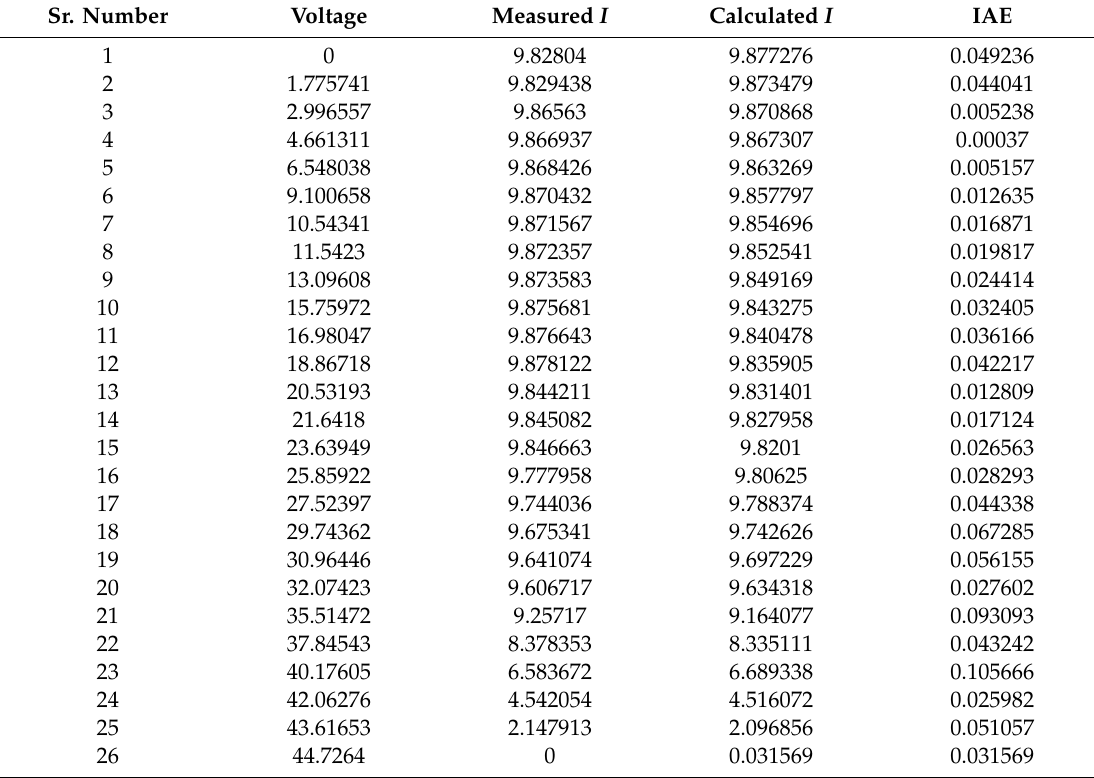
Figure 19. P–V curves for the double-diode practical system at different irradiance and temperature levels.